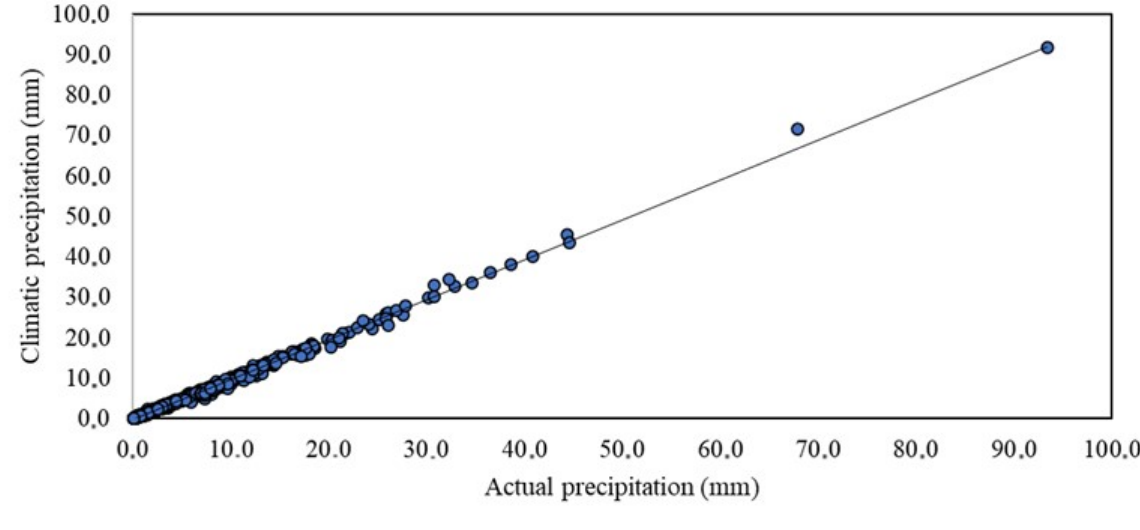
Figure 6. Relationship between the actual precipitation and climatic precipitation.